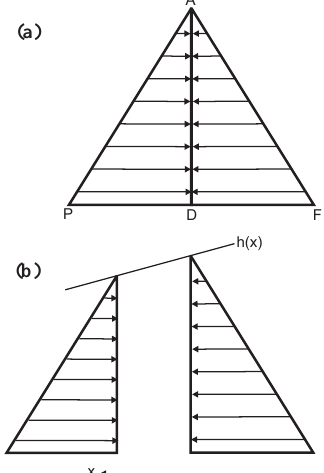
Figure 4. (a) At any location the lithostatic stress increases linearly with depth from zero at the ice surface to ρ gH at the base; the litho- static stress from ice on the right of the vertical line A–D is balanced by an equal but opposite lithostatic stress from ice on the right and the area of triangle A–D–F equals that of triangle A–D–P. (b) Gra- dients in lithostatic stress are associated with a sloping ice surface, h(x) , resulting in a smaller lithostatic stress in the downslope direc- tion; the difference between the areas of both triangles is a measure of the gravitational driving stress responsible for glacier